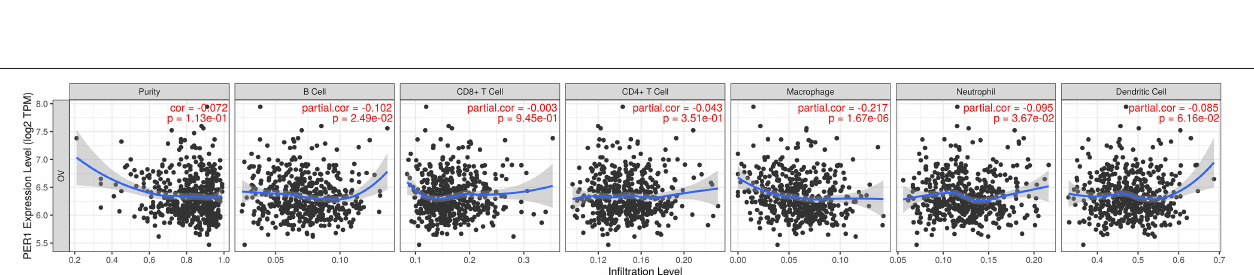
the biological function and mechanism of PER1 in tumors remain